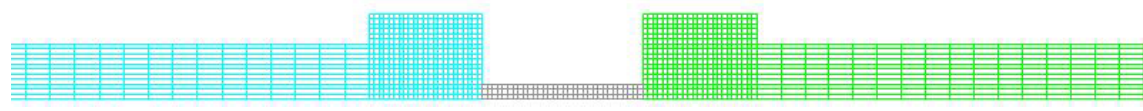
Figure 4. Structured mesh in the modified SHTB Model-2.